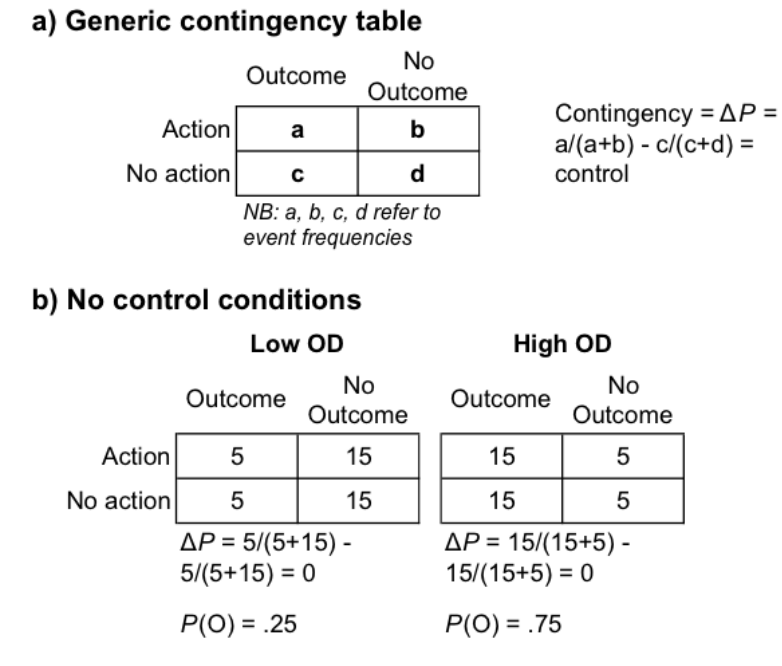
Figure 1. Generic (a) and specific (b) contingency relationships between the occurrence of an action and the occurrence of an outcome in conditions (b) in which there is "no control’"over the outcome. NB. The term "outcome density" (OD) refers to the probability of an outcome occurring over all events,